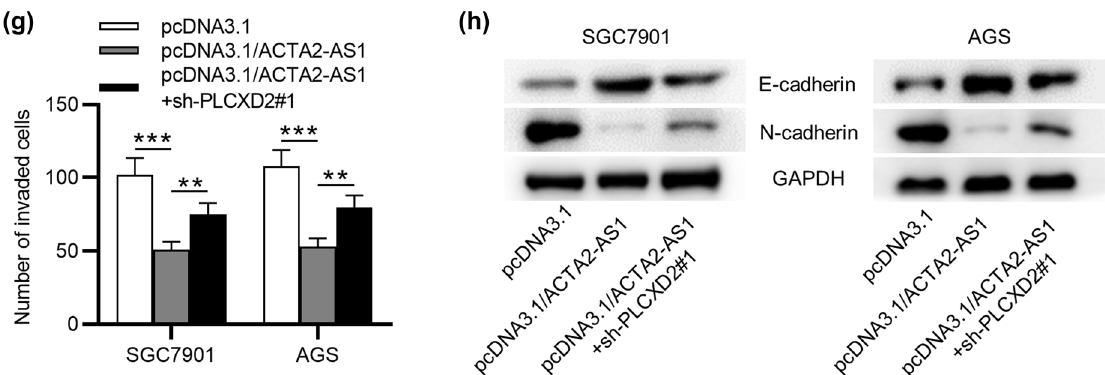
Figure 5: PLCXD2 knockdown reverses the inhibitory e ff ect of ACTA2 - AS1 overexpression on GC cellular behaviors. ( a ) The knockdown e ffi ciency of sh - PLCXD2#1/2 in GC cells was examined by RT - qPCR, and sh - PLCXD2#1 was selected for the following rescue assays. ( b and c ) CCK - 8 assays and colony formation assays were conducted to detect the viability and proliferation of GC cells transfected with pcDNA3.1/ ACTA2 - AS1 or cotransfected with pcDNA3.1/ACTA2 - AS1 and sh - PLCXD2#1. ( d – g ) Wound healing assays and Transwell assays were utilized to detect the migration and invasion of GC cells with the above transfection. ( h ) Protein levels of EMT markers ( E - cadherin and N - cadherin ) in GC cells were determined by Western blot analyses. * p < 0.05, ** p < 0.01, and *** p < 0.001.